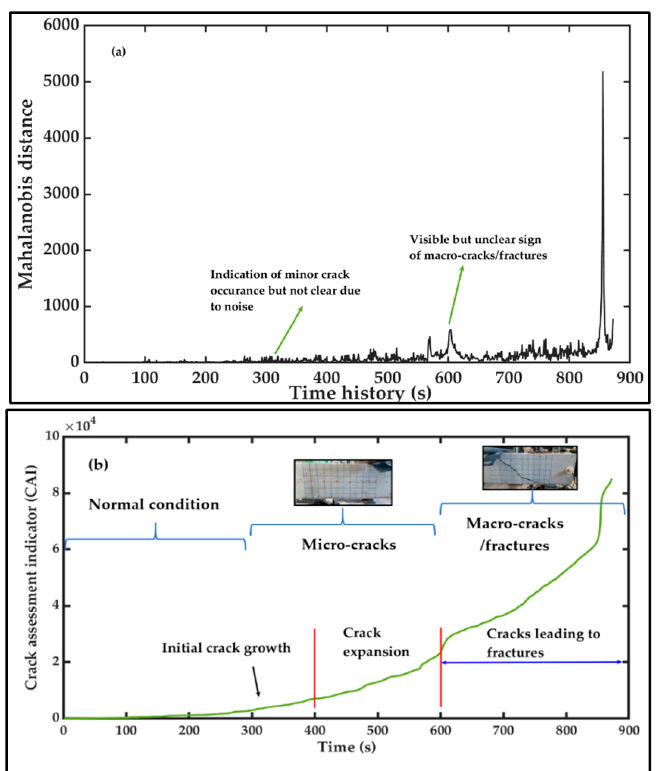
Figure 12. Time history of the RC beam: ( a ) Boruta-Mahalanobis system (BMS) plot and ( b ) final crack assessment indicator (CAI).